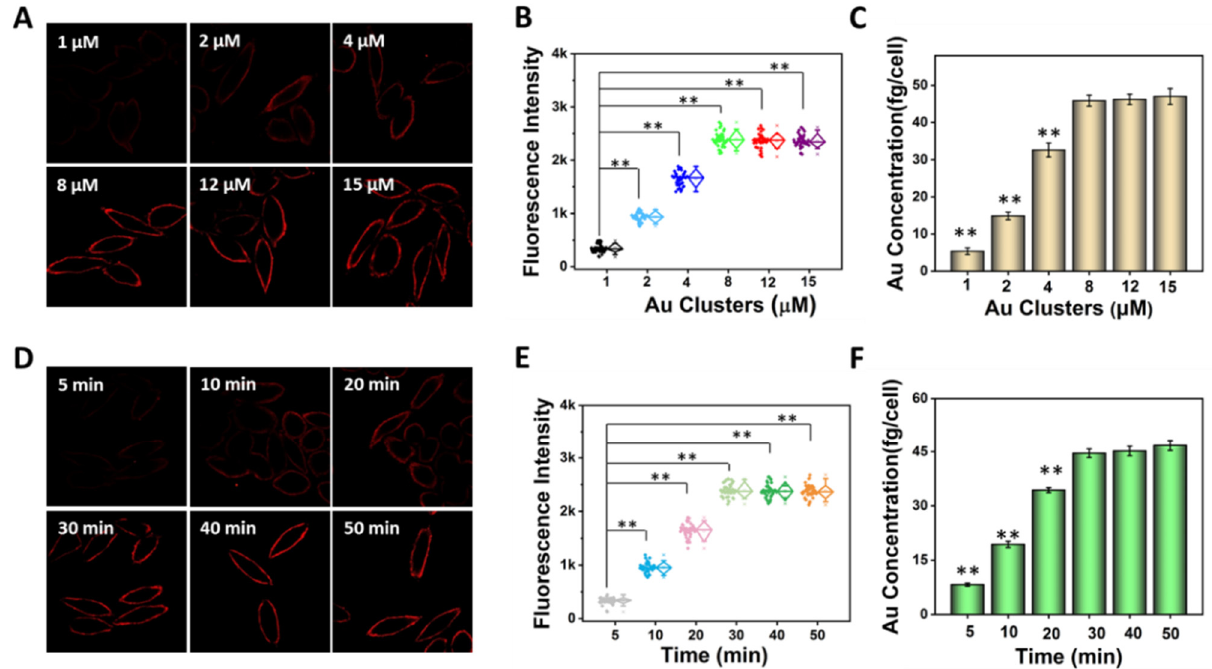
Figure 5. Optimization of labeling conditions of Au 26 cluster for MT1-MMP. ( A ) Fluorescence imaging of Siha cells treated with different concentrations of Au clusters for 30 min. ( D ) Fluorescence imaging of Siha cells treated with 8 μ M Au clusters at different times. ( B , E ) Fluorescence intensity analysis corresponds to A and D. Each point represents the fluorescence intensity of a cell. ( C , F ) The average amount of Au determined by ICP-MS on Siha cells corresponding to A and D. ** p < 0.01.